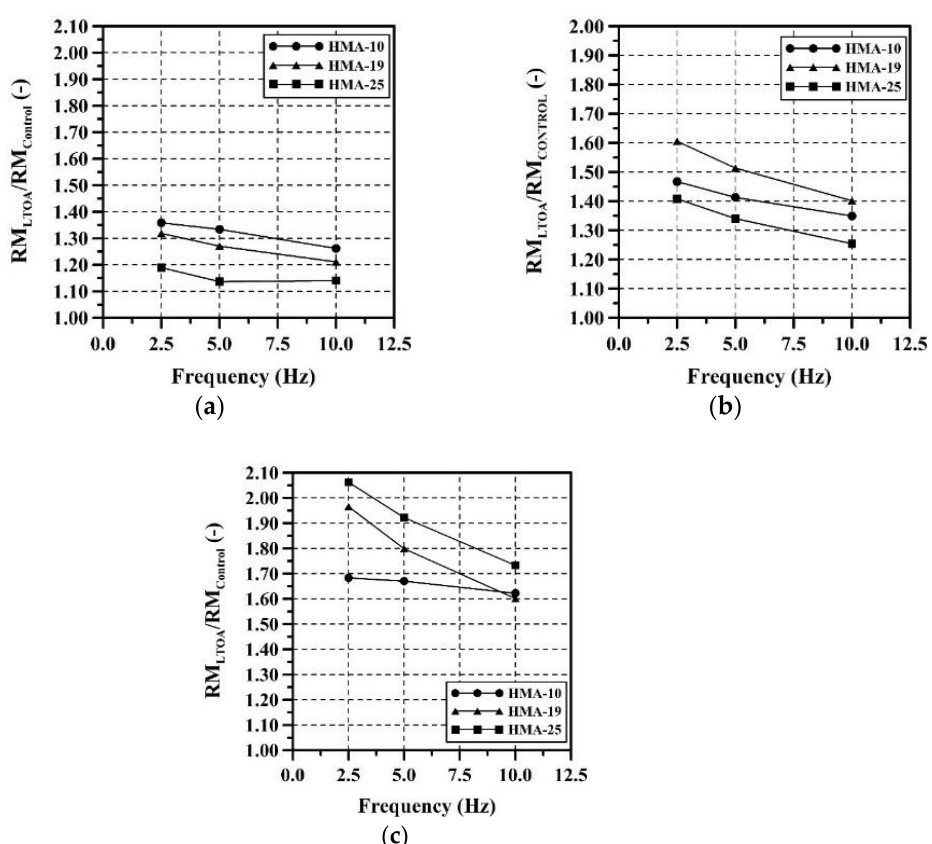
Figure 5. RM STOA /RM Control ratio at ( a ) 10 °C, ( b ) 20 °C, and ( c ) 30 °C.